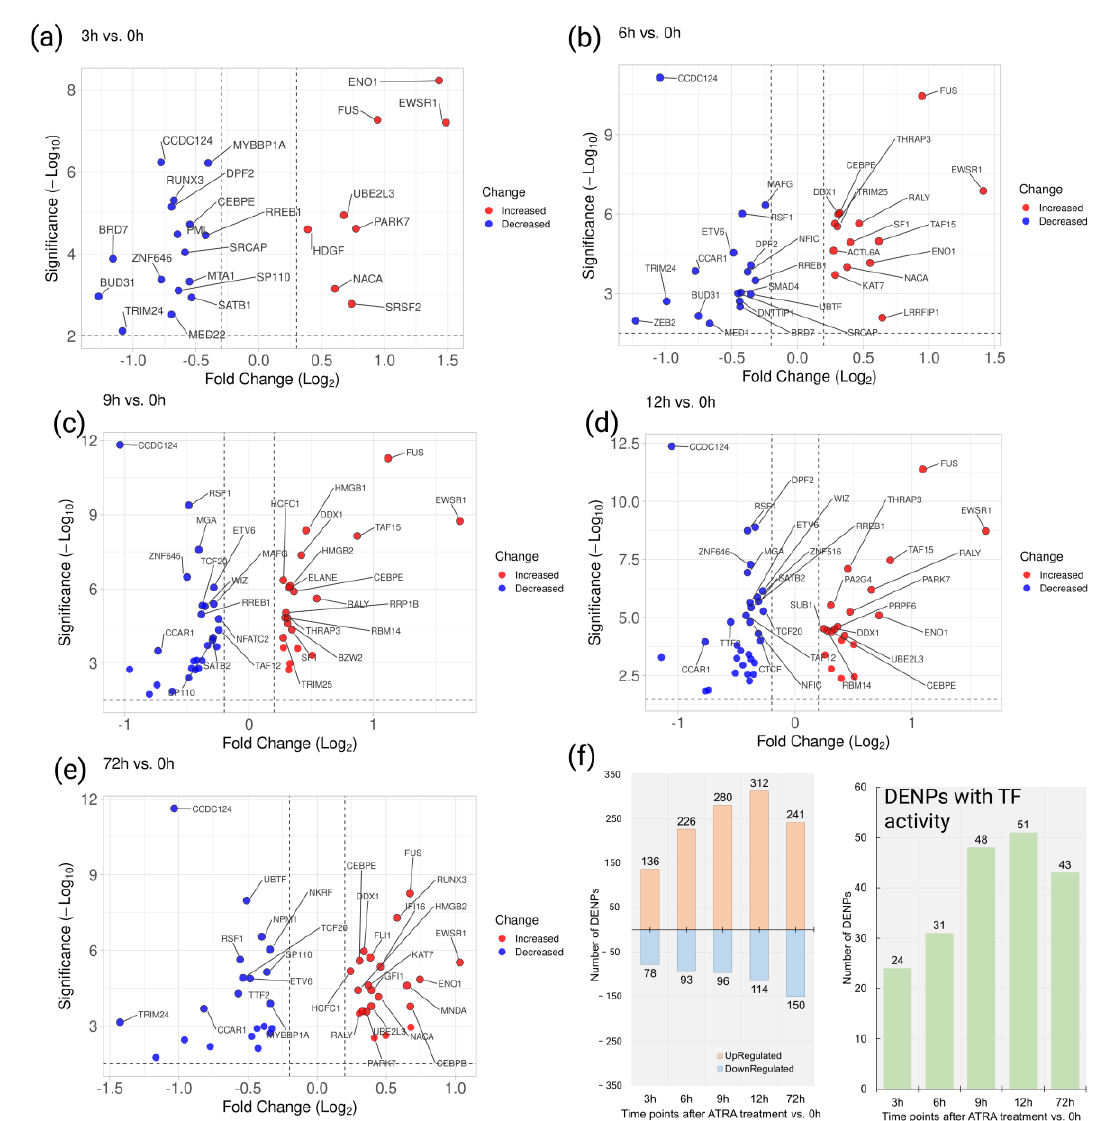
Figure 4. Results of proteomic quantitative 2D/TMT-profiling of the HL-60 nuclear fraction during ATRA-induced granulocytic differentiation. ( a – e ) Scatter plots show the differences in abundance for nuclear proteins with transcription factor (TF) activity at 3, 6, 9, 12, and 72 h after the ATRA treatment, respectively. Significantly up- and downregulated proteins (FDR < 0.005, S0 = 0.1) are shown by red and blue dots, respectively. In the cases of time points 9, 12, and 72 h, names are shown for the top thirty most differentially expressed nuclear proteins (DENPs). ( f ) Number of all DEPs and DEPs with TF activity at 3, 6, 9, 12, and 72 h after the ATRA